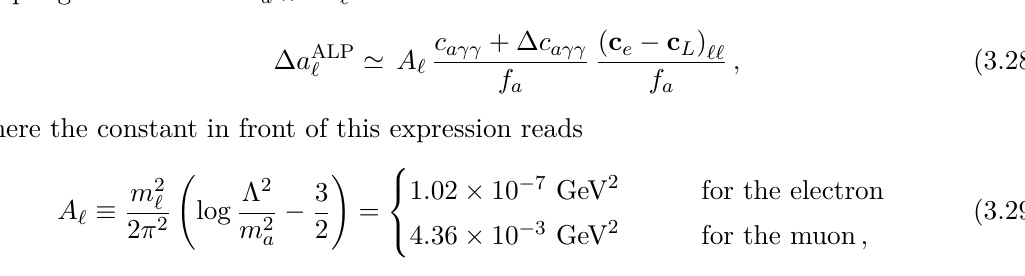
ALP exchange can contribute to both ∆ a loop, as depicted in figure 4. In the chirality-flip basis eq. (2.9), the ALP-fermion